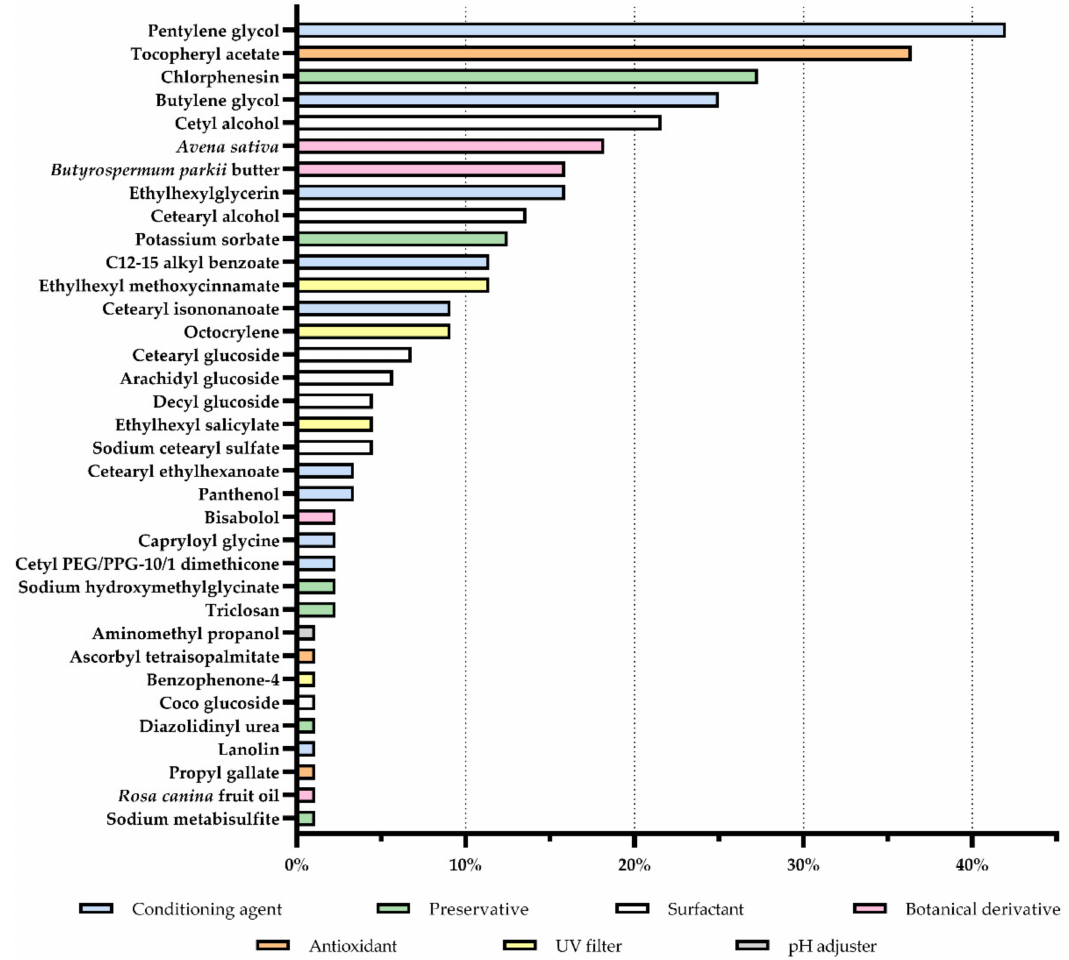
Figure 4. Prevalence of allergens in products for sensitive skin. (UV = ultraviolet).